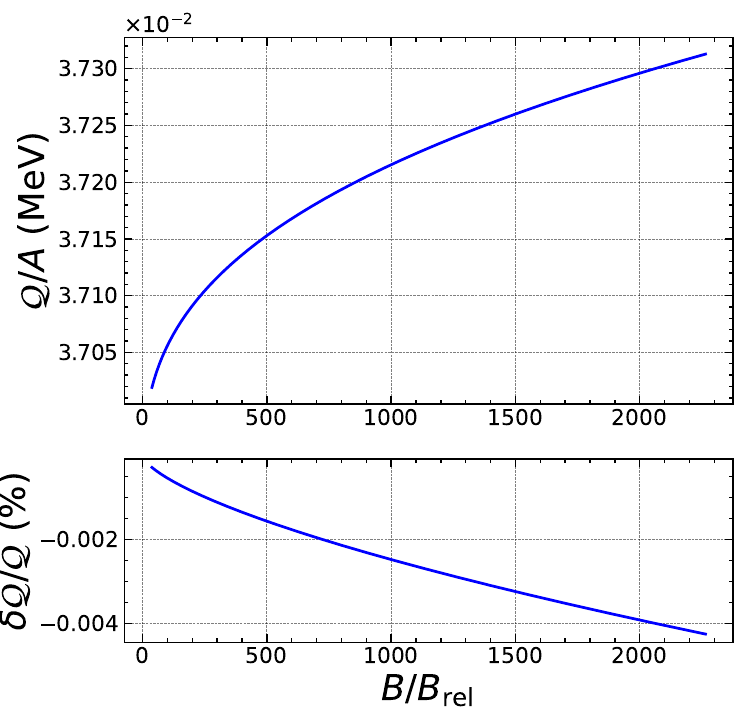
Figure 8. Same as Figure 7 in the strongly quantizing regime.